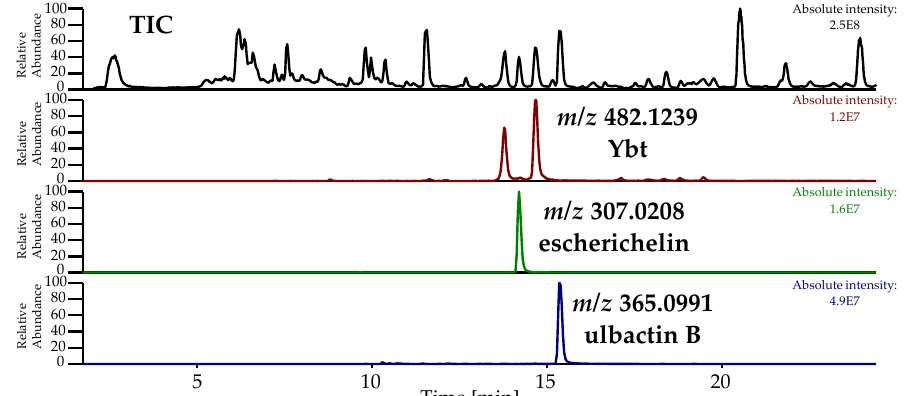
Figure 6. Total ion chromatogram (TIC) and extracted ion chromatogram (EIC) of pre-concentrated culture supernatant of EcN during the isolation of ulbactin B, displaying Ybt ([M + H] + : C 21 H 28 N 3 O 4 S 3 + ,